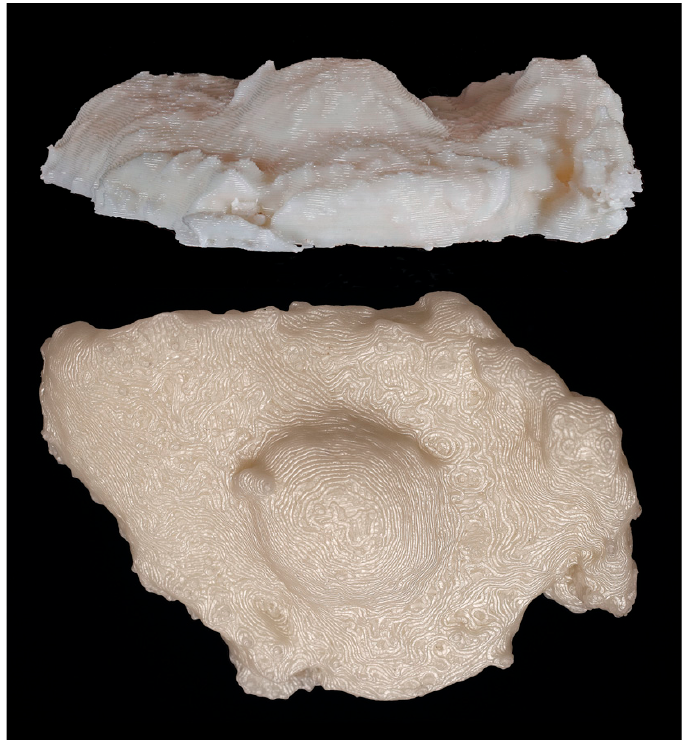
Figure 7. Lateral and superior views of physical 3D model of Case 1 printed via material extrusion.